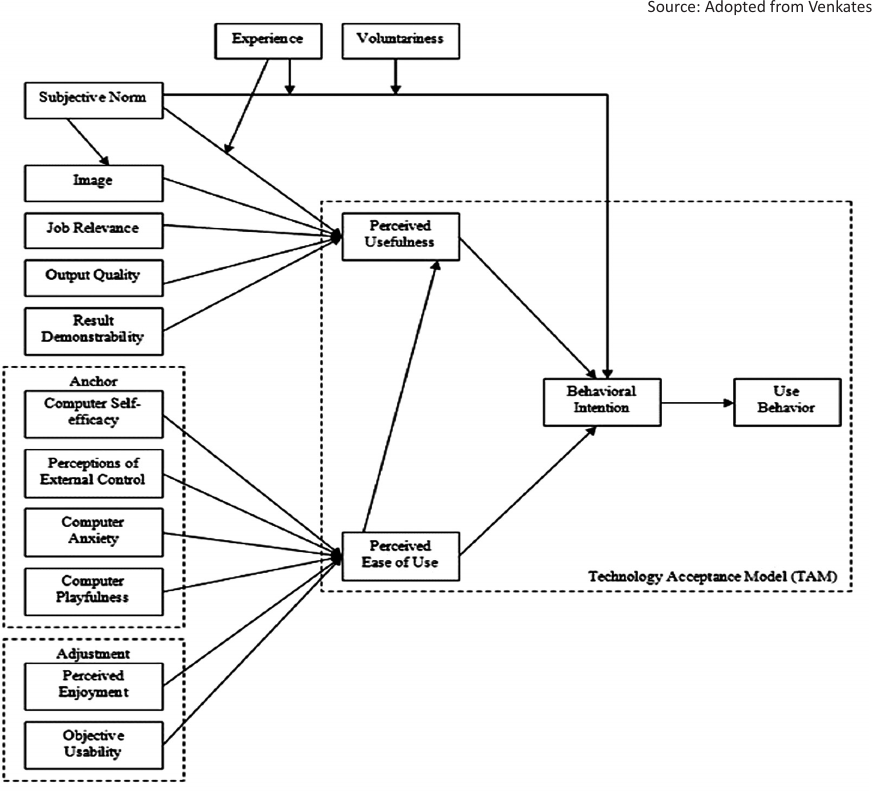
Figure 1. Path analysis